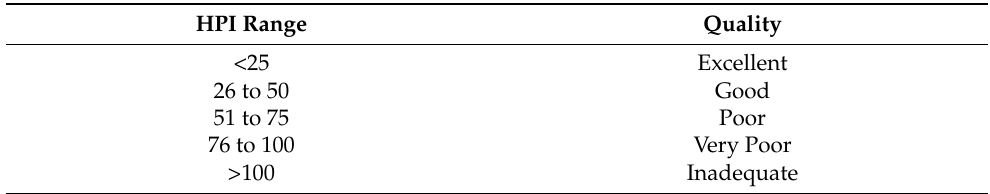
Table 6. Water quality ranking using pollution index for heavy metals (HPI). Source Elumalai, Brindha, Lakshmanan (2017)